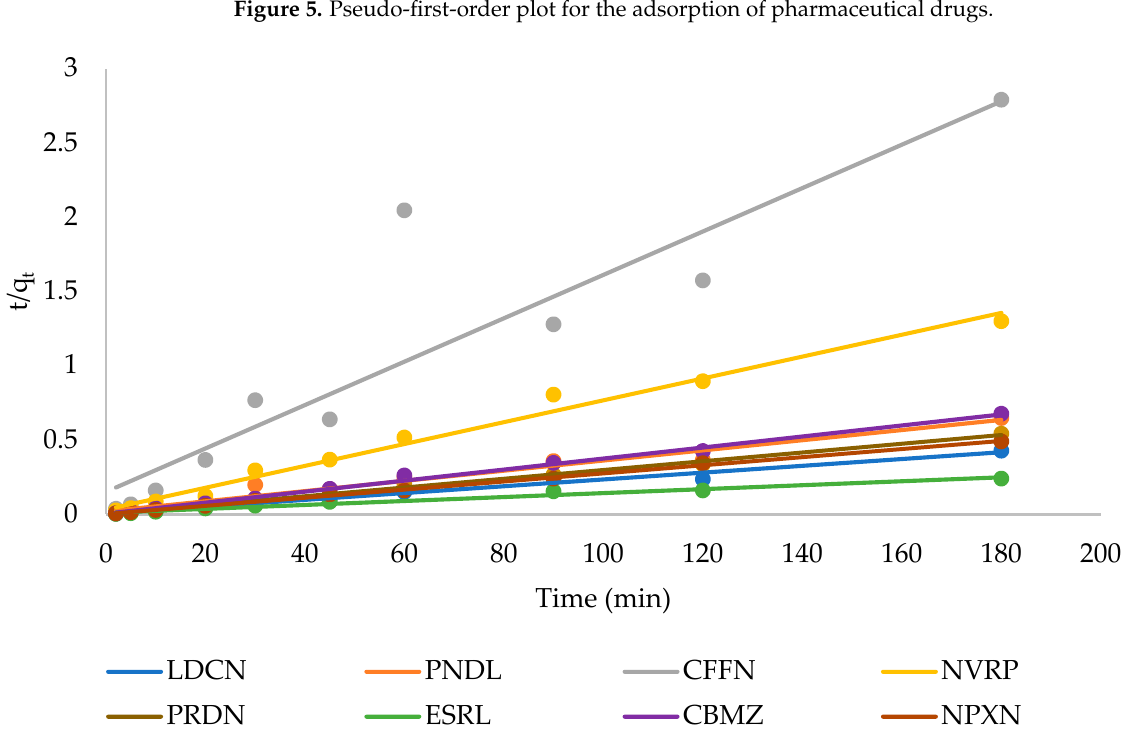
Figure 6. Pseudo-second-order plot for the adsorption of pharmaceuticals. Table 2. Kinetic parameters of pseudo ‐ first ‐ order and pseudo ‐ second ‐ order. 𝑞 (cid:3032) (cid:3032)(cid:3051)(cid:3043) μ g g − 1